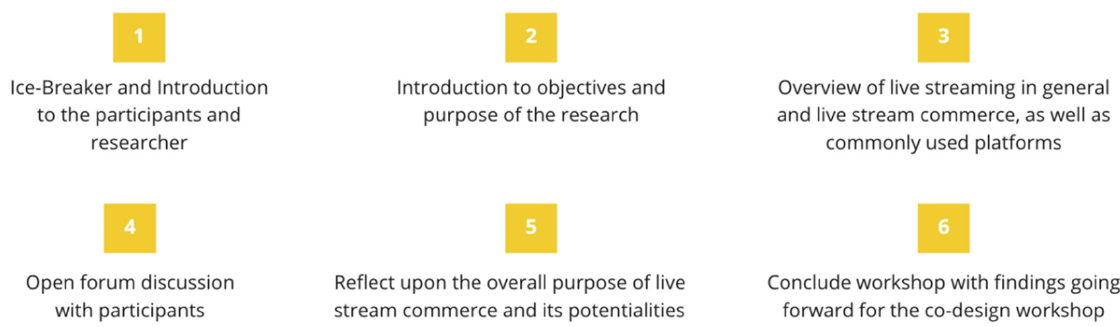
Figure 7. The six stages of the Participatory Design